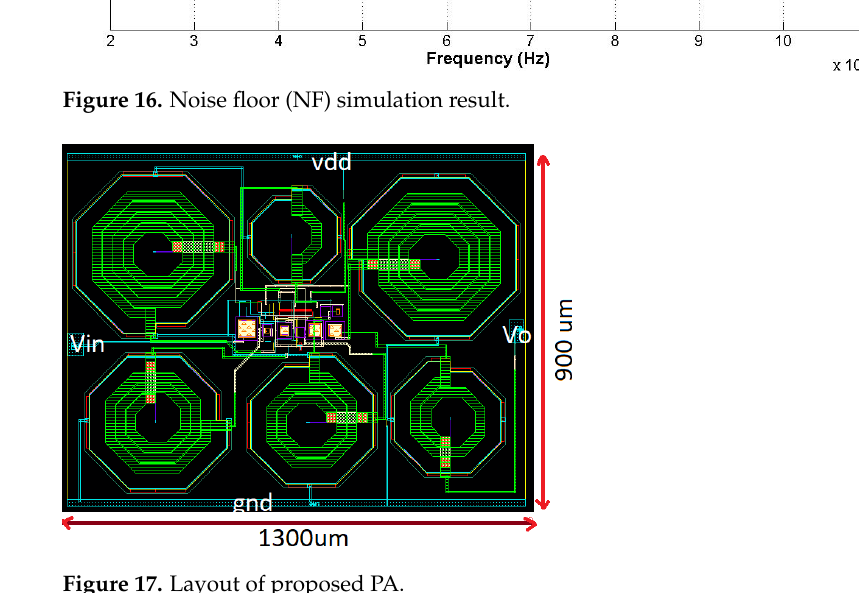
Figure 17. Layout of proposed PA. Table 2. Postlayout simulation results of proposed UWB-PA in comparison with that of other published CMOS